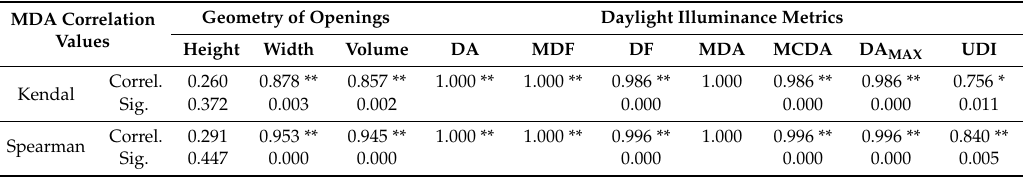
Table 8. Mean DA Correlation Values.